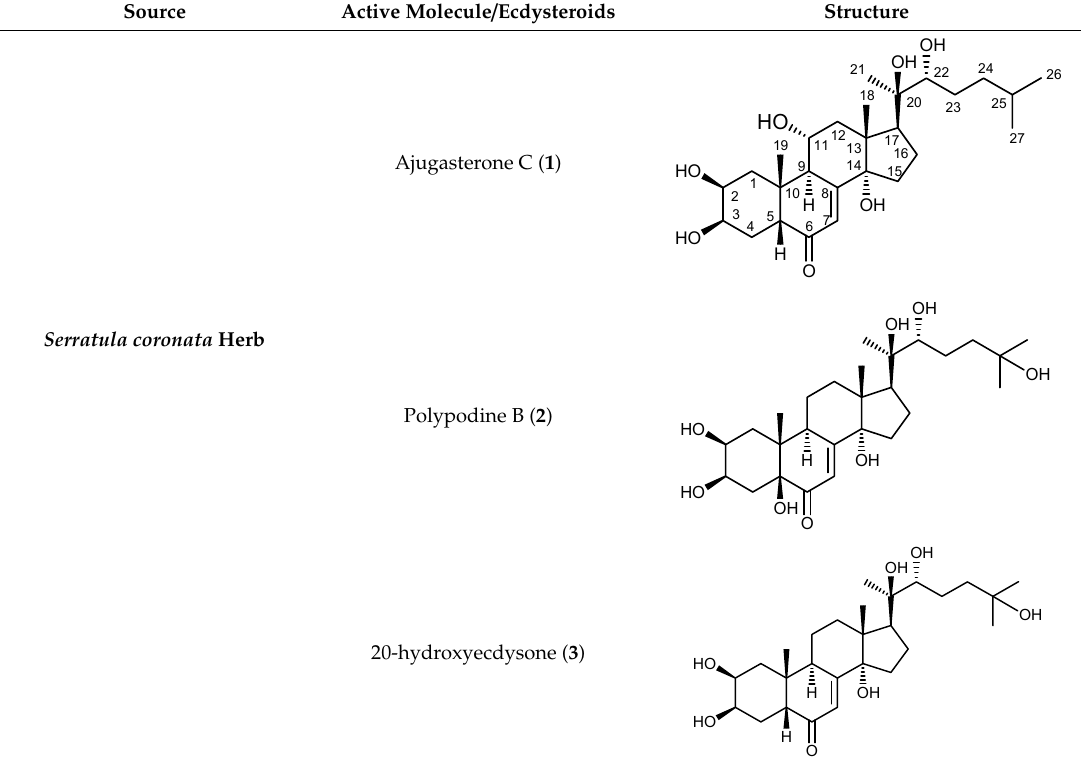
Table 1. The chemical structures of dominant phytoecdysteroids from the S. coronata herb. Source